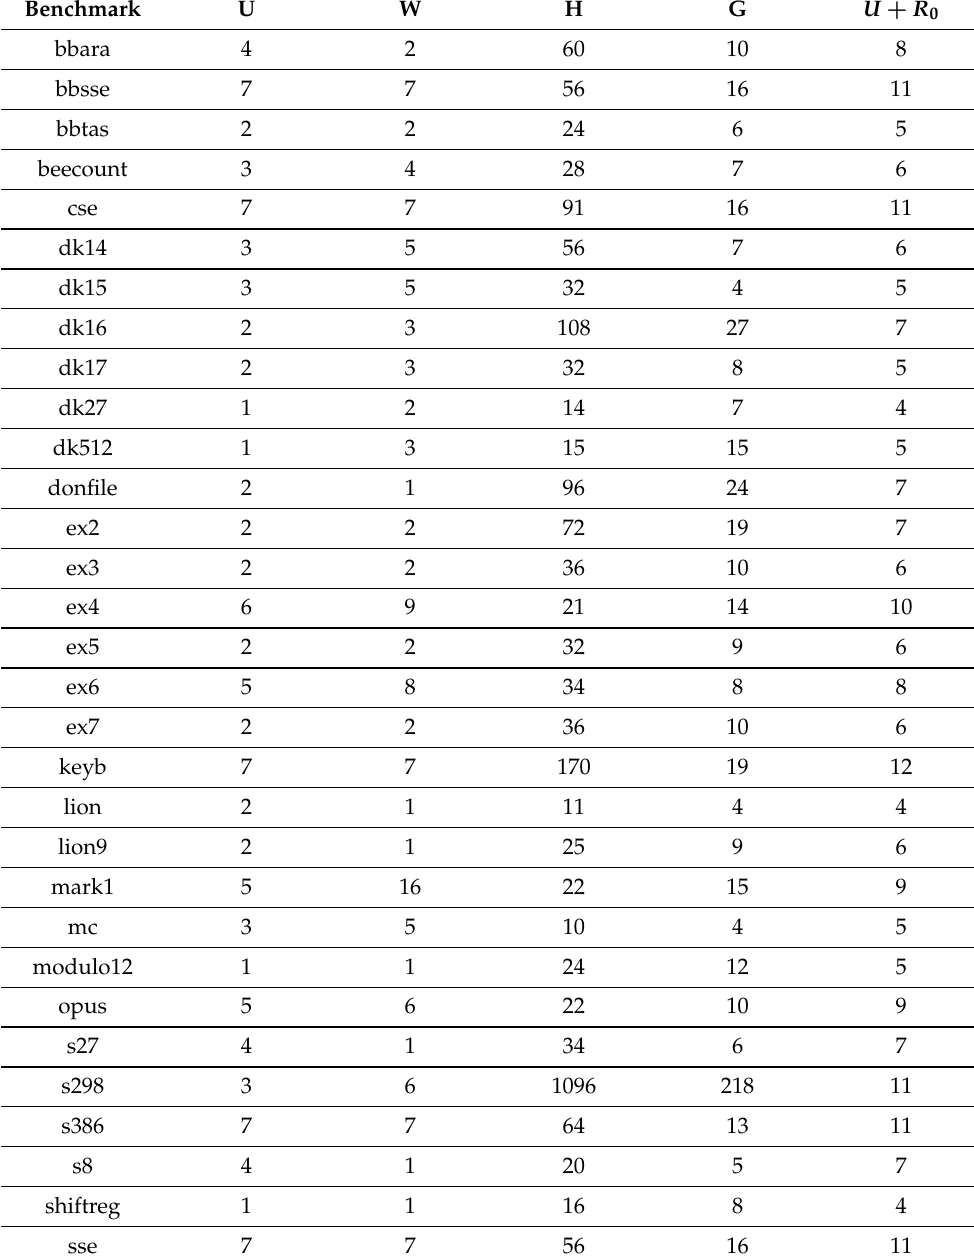
Table 9. Characteristics of benchmarks from LGSynth93